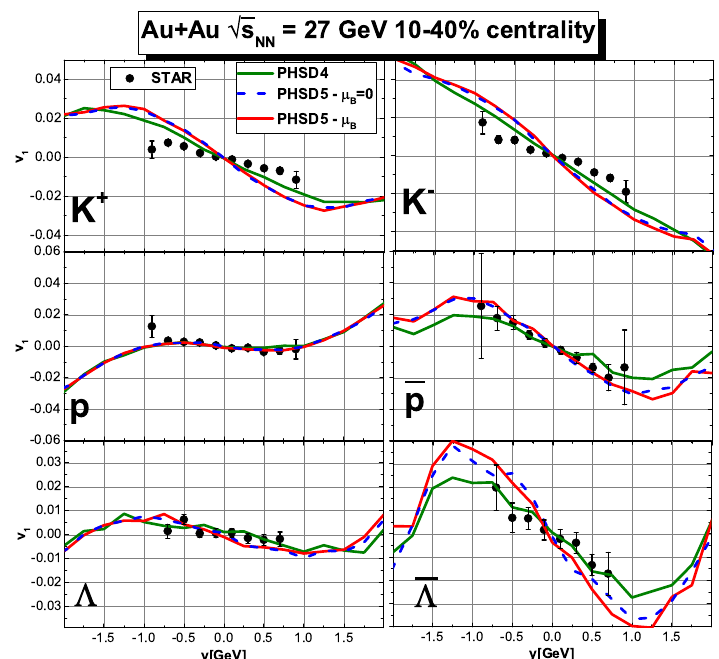
√ s NN = 27 GeV for PHSD4.0